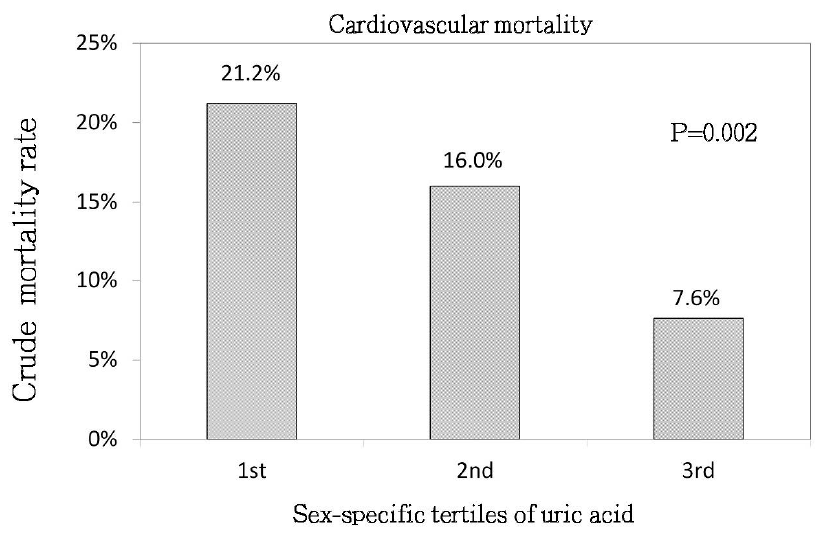
Figure 2. Crude analysis of cardiovascular mortality rate between the sex-specific tertiles of serum uric acid levels ( p = 0.002).